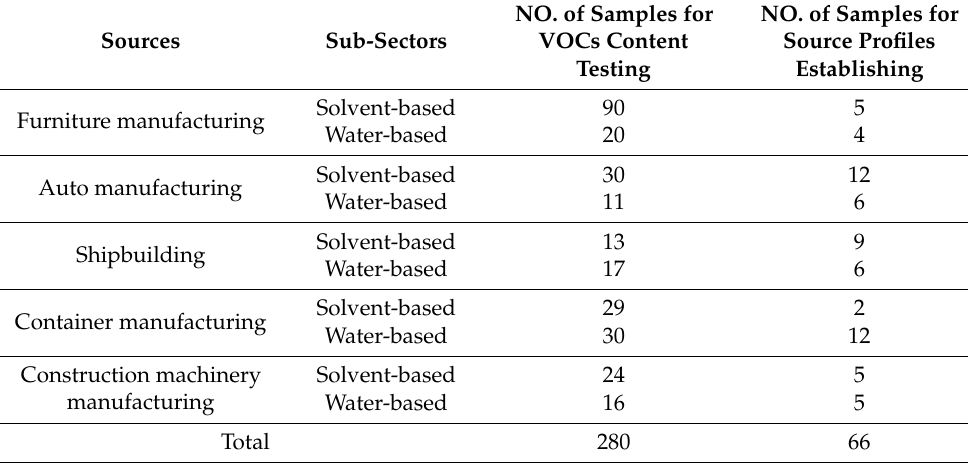
Table 1. Number of samples collected at different source sectors for the localization of VOCs emission factors and source